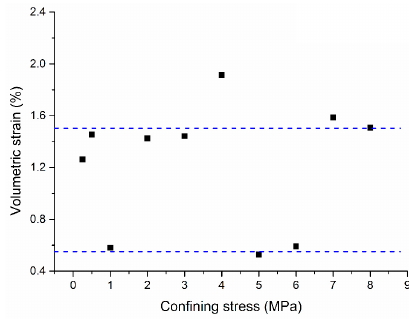
Figure 20. Volumetric strain at the crack initiation threshold for coal specimens in group 1.